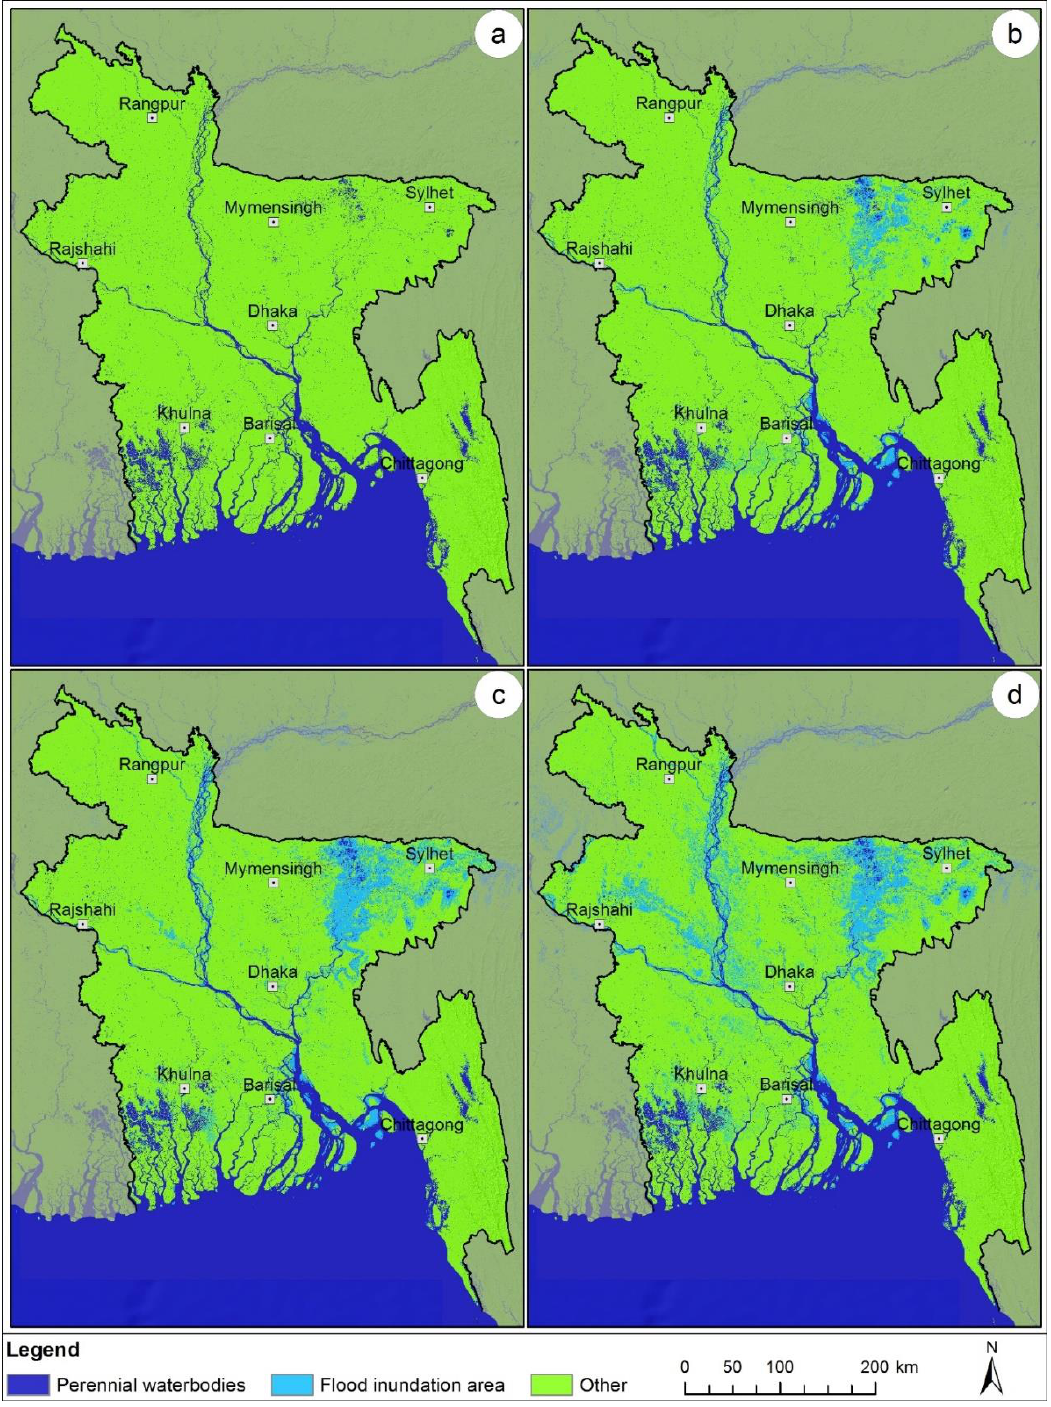
Figure 5. Comprehensive flood inundation map of Bangladesh for the months of ( a ) March, ( b ) April, ( c ) June, and ( d ) August 2017.